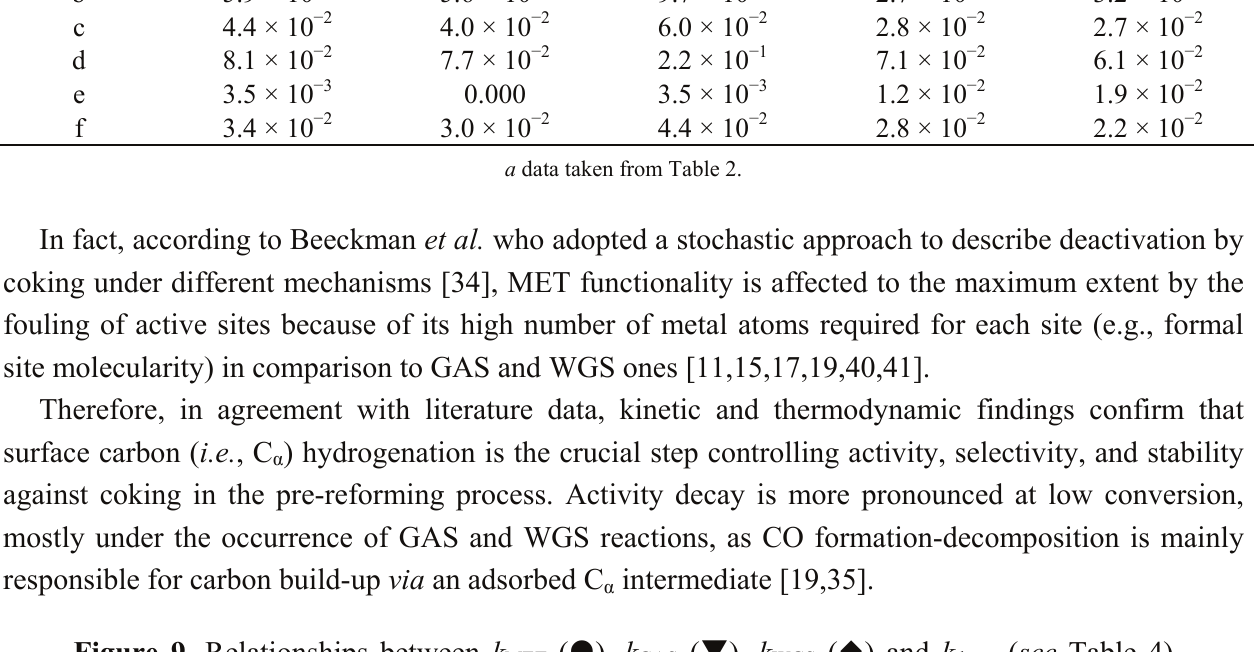
(  ), k (  ), k (  ) and k ( see Table 4) MET GAS WGS deact